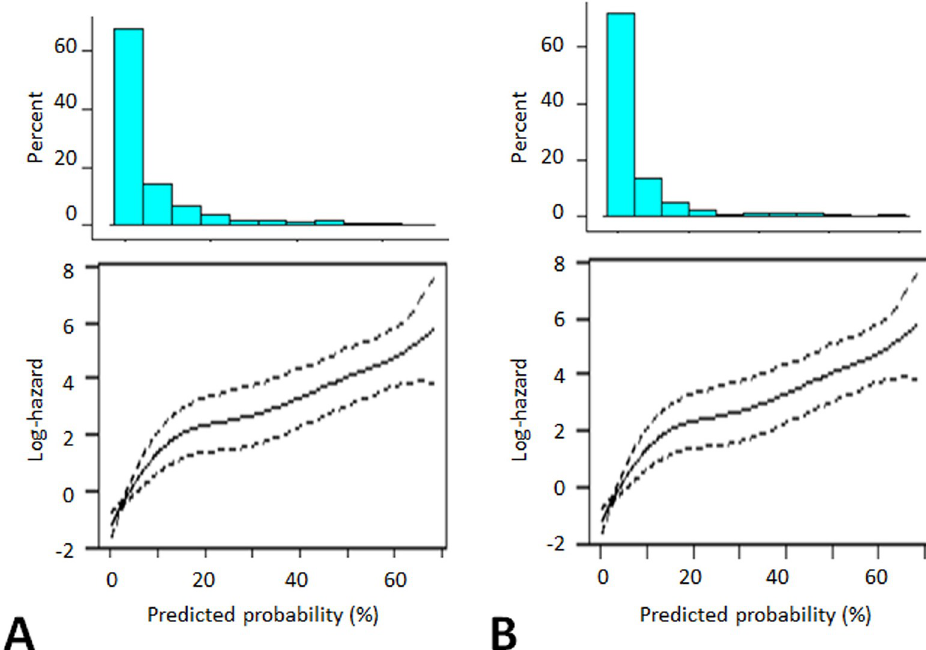
Fig 2. Relationships between risk of primary outcome and its predicted probabilities at model selection stage. The figure shows the relationships between the risk of the primary outcome and its predicted probabilities. Histograms of the probabilities and the log hazards of the primary outcome are shown in the upper and lower panels, respectively. A: RF_time_all. B: RF_time_v8. Abbreviation: RF, Random Forest.